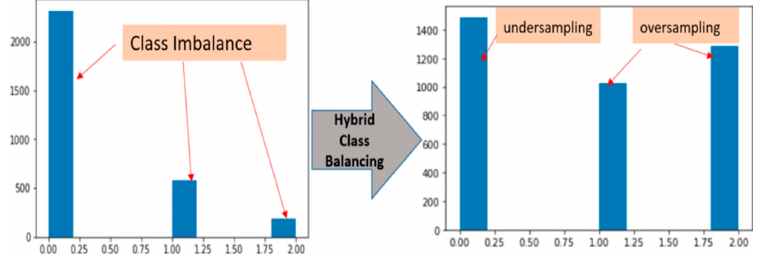
Figure 4. Hybrid class balancing with under-sampling and